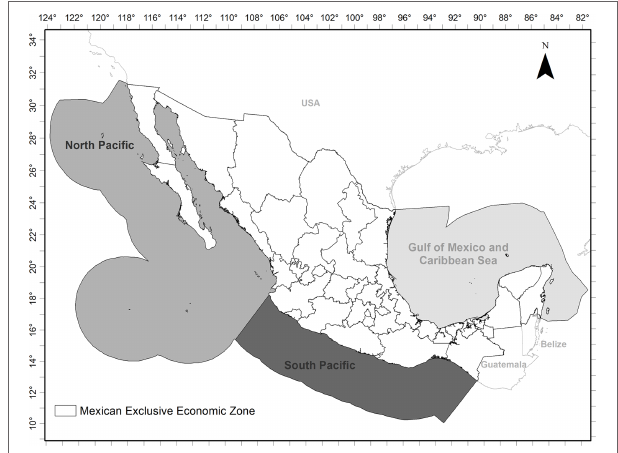
FIGURE 1 | The main fishing regions in Mexico based on official management and policies ( DOF, 2020 ). In grayscale are the North and South Pacific, the Gulf of Mexico, and the Caribbean Sea regions, and the black outline indicates the Exclusive Economic Zone of